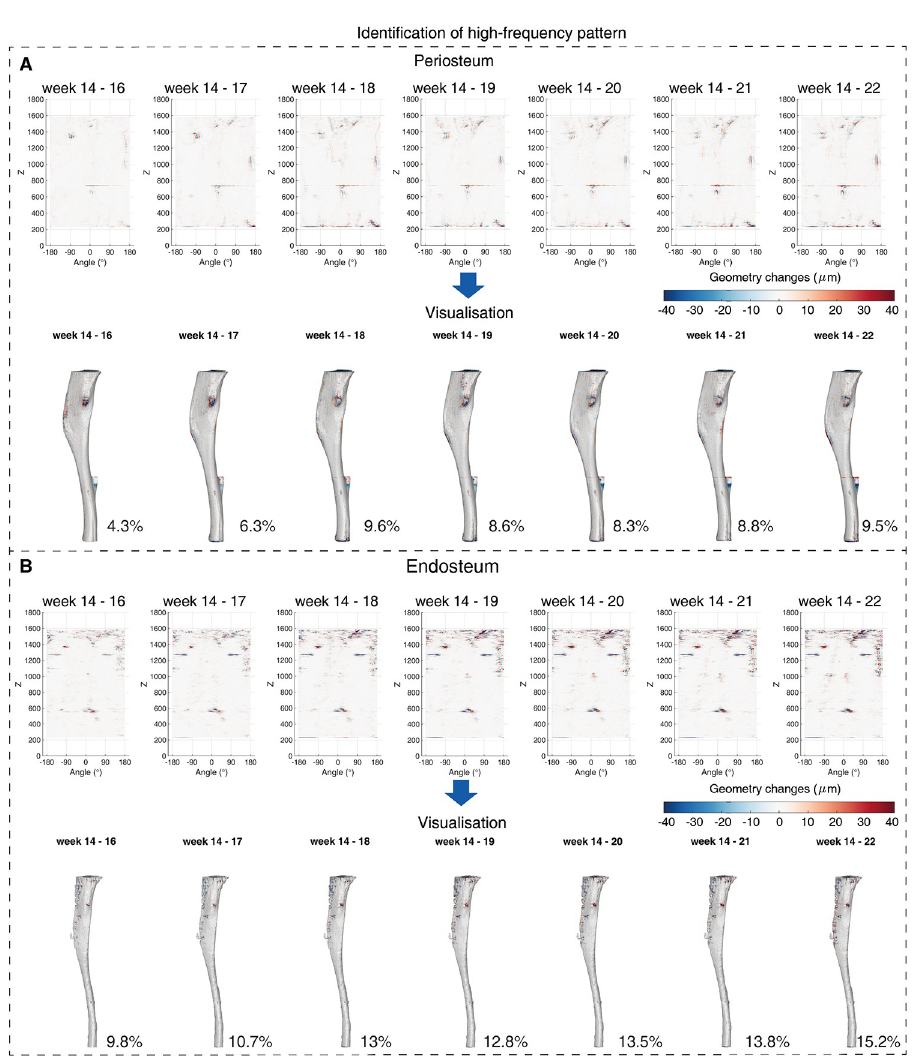
Fig 5. Identified high-spatial frequency activity at bone surface from week 14 to week 22 of a wild-type mouse tibia. (A) The identified hight frequency activity patterns on periosteum (top) and the corresponding visualisation (bottom). The activation rate is presented at the bottom right. (B) The identified high frequency activity patterns on endosteum (top) and the corresponding visualisation (bottom) with the activation rate at the bottom right. In sub- figures, the patterns from left to right correspond to the geometric changes from week 14 to